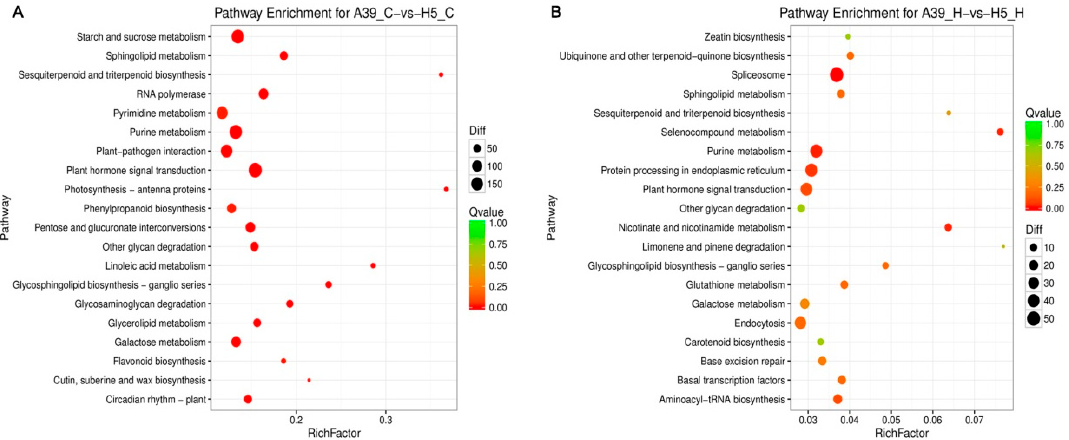
Figure 4. KEGG enrichments of annotated DEGs across three comparisons of normal condition ( A ) and heat stress ( B ). The y -axis indicates the KEGG pathway and the x -axis indicates the enrichment factor. A high q-value is represented by light blue, and a low q-value is represented by dark blue.